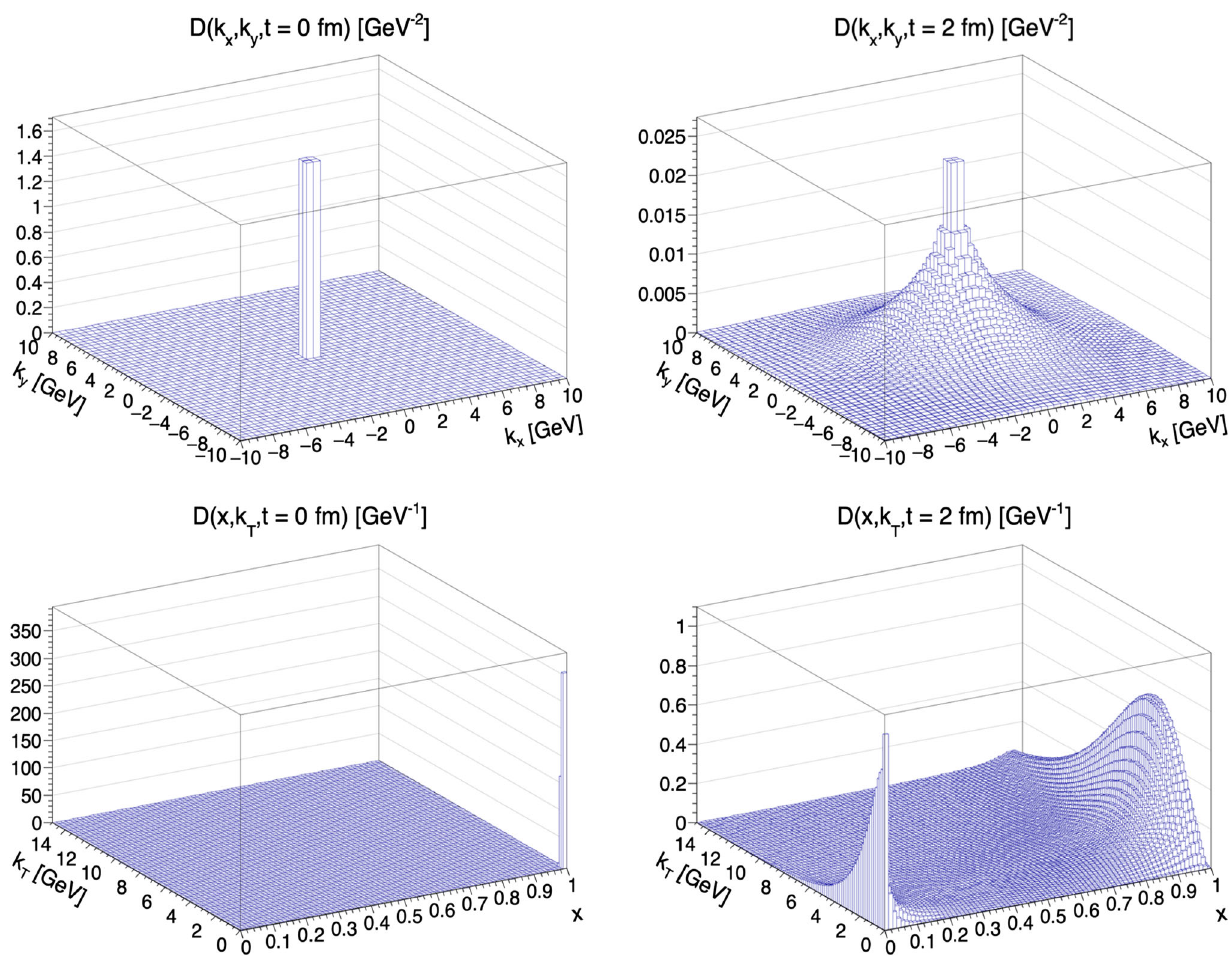
Fig. 6 2D distributions of k x vs. k y (upper row) and x vs. k T (lower row) from the Monte Carlo program MINCAS for the evolution time values: t = 0 and 2fm (LHS and RHS figures,